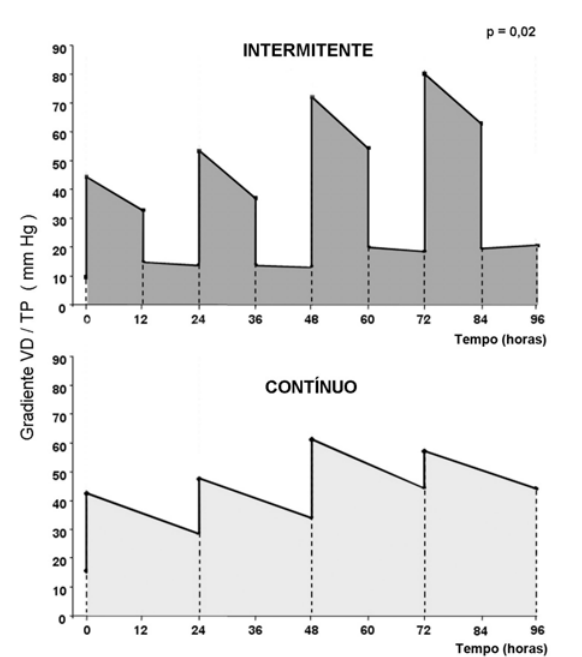
Fig. 1 - Diagrama da sobrecarga sistólica do VD. Painel superior: Gradiente VD/TP (mmHg) do grupo submetido a 12 horas de sobrecarga sistólica do VD, alternadas com 12 horas de descanso. Painel inferior: Gradiente VD/TP (mmHg) do grupo submetido à sobrecarga sistólica contínua do VD. (* p = 0,02). VD - Ventrículo Direito;TP - Tronco